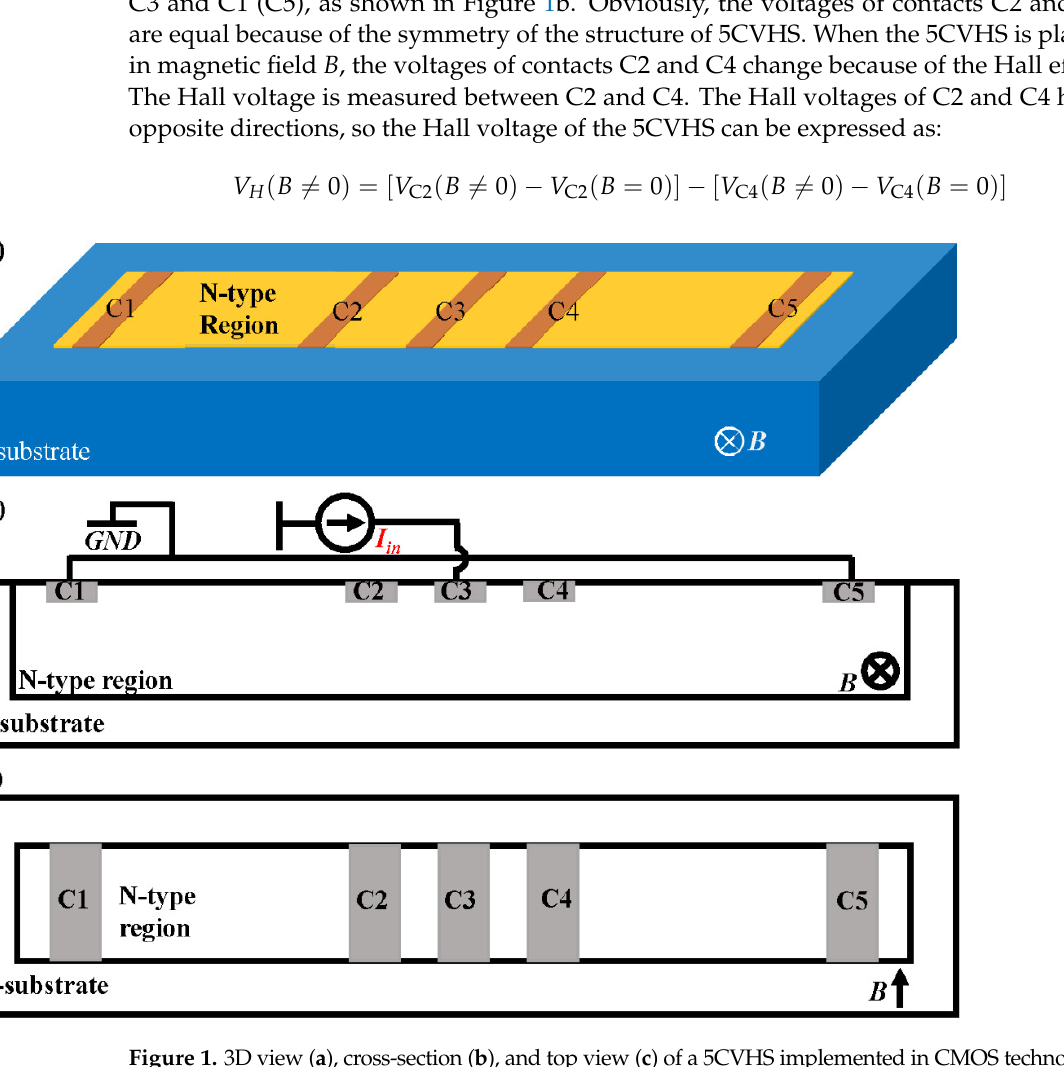
Figure 1. 3D view ( a ), cross-section ( b ), and top view ( c ) of a 5CVHS implemented in CMOS tech-